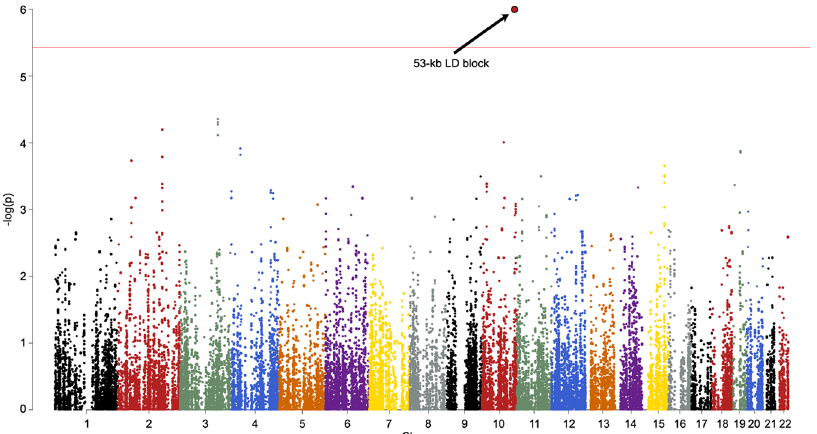
Figure 4. Manhattan plot of the shared variance of NeanderScore associated brain and skull changes. Manhattan plot showing the chromosomal position and significance of association between the shared variance of all Neanderthal-associated brain measures for each Neanderthal-derived SNP. Red line indicates Bonferroni- corrected threshold of p < 0.05 for the effective number of SNPs in the analysis. The arrow points to the significant 53-kb LD block on chromosome 10 containing 18 SNPs. See also Table 2.